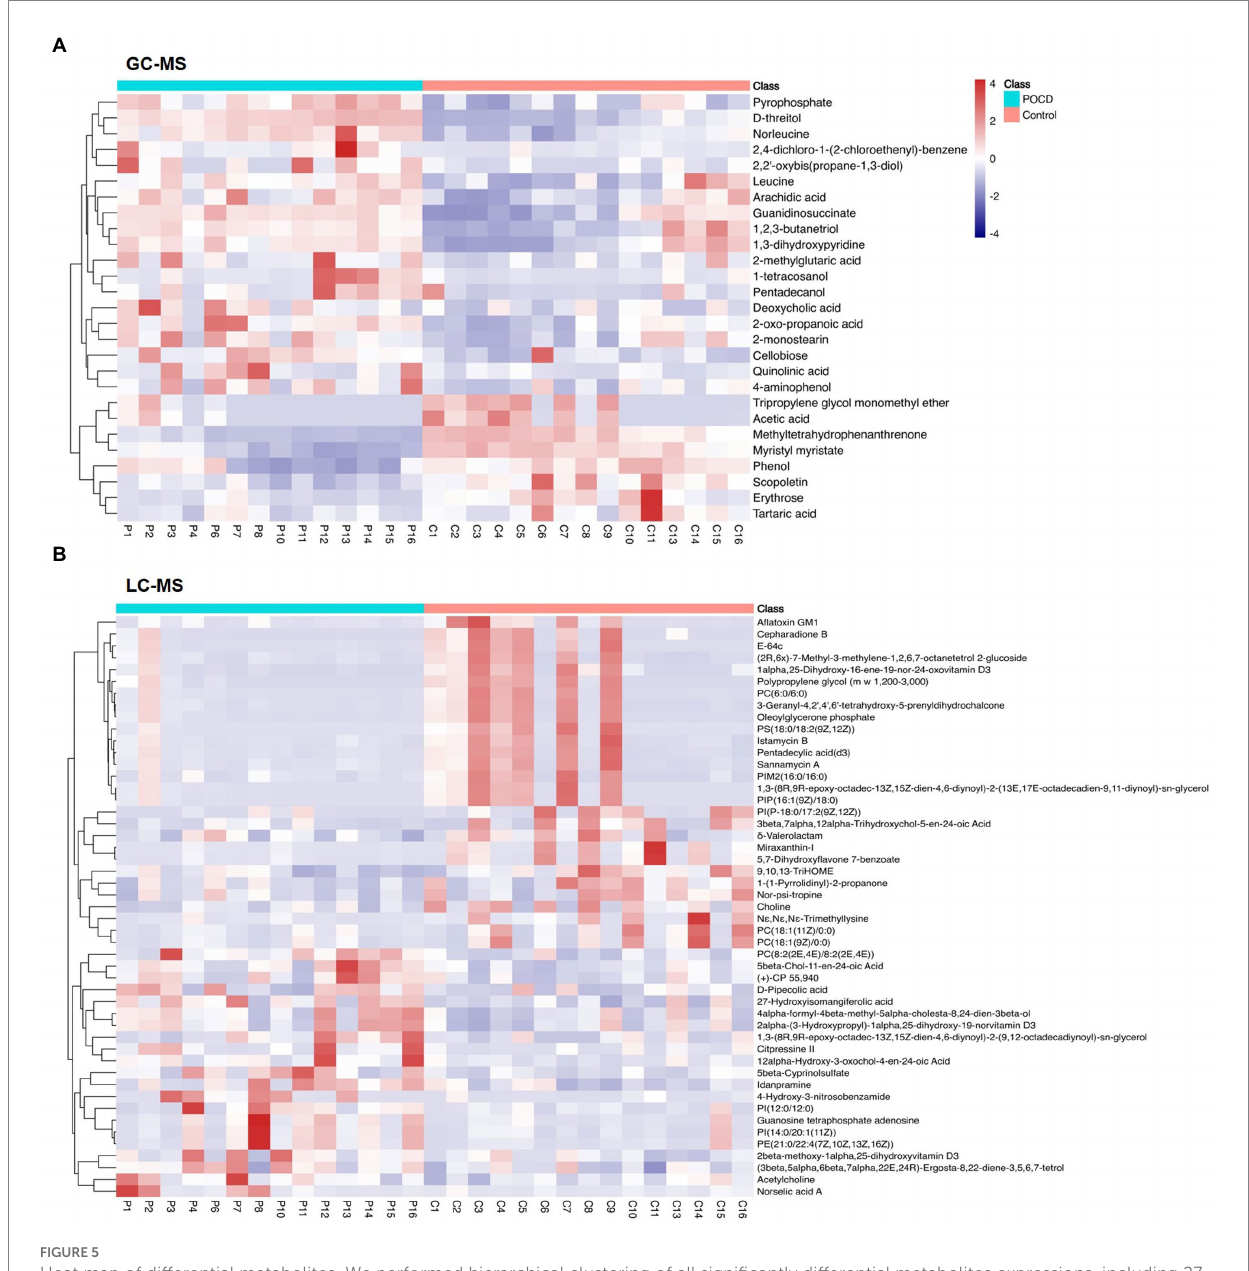
FIGURE 5 Heat map of differential metabolites. We performed hierarchical clustering of all significantly differential metabolites expressions, including 27 metabolites in GC–MS (A) , and 125 metabolites in LC–MS (B) . The horizontal coordinates indicate sample names and the vertical coordinates indicate differential metabolites. The colour ranges from blue to red, a redder colour indicates a higher abundance of expression of the differential